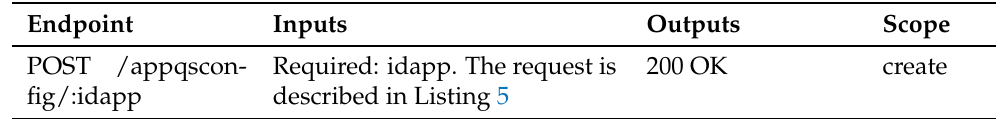
Table 6. API endpoint specification: